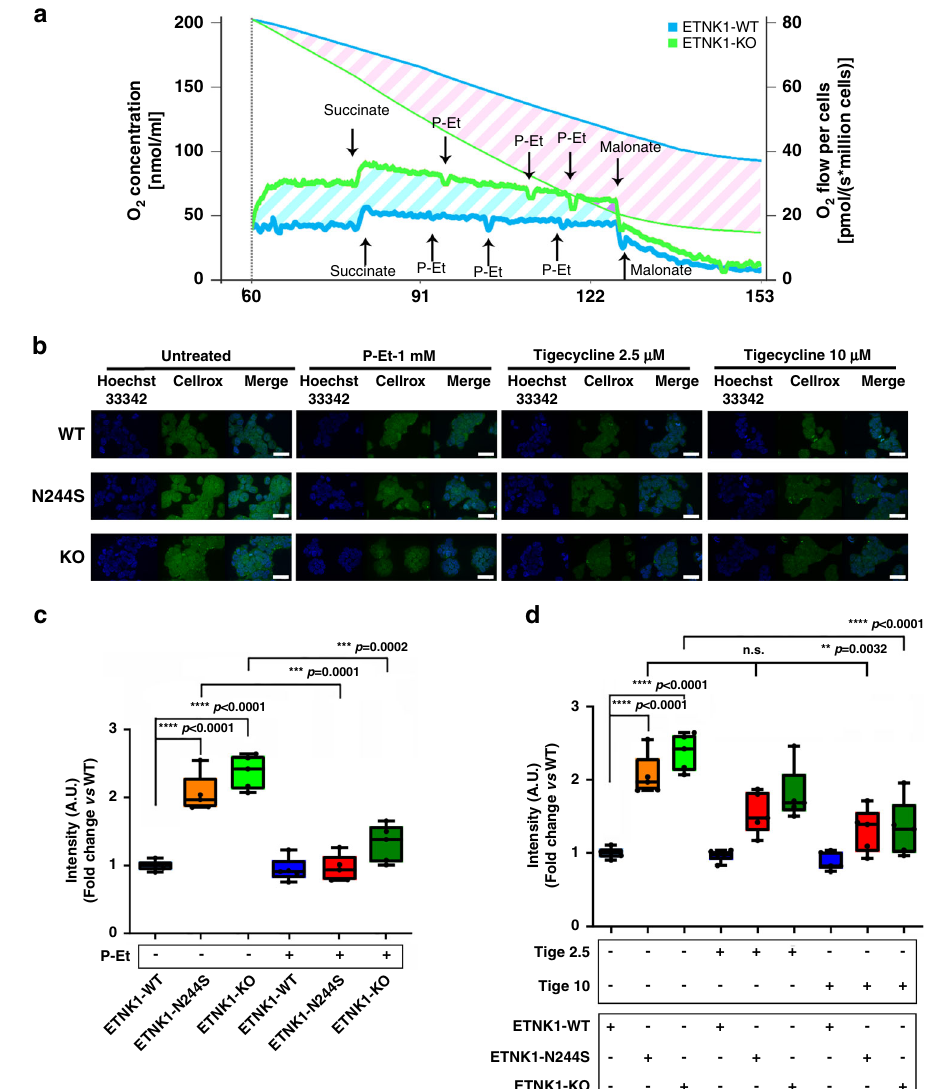
Fig. 3 Mitochondria respiration and ROS production. a Representative graph of O 2 consumption rate (pmol/(s*10 6 cells)) and O 2 concentration (nmol/ ml) in ETNK1-WT and KO CRISPR lines ( n = 4), measured by high-resolution respirometry Oroboros O2K (1 million cells). The thick blue and green lines represent the oxygen consumption rate of ETNK1-WT and KO cells, respectively; the thin blue and green lines show the oxygen concentration in ETNK1- WT and KO oxygraph chambers, respectively. The diagonal cyan and pink stripes highlight, respectively, the difference in oxygen consumption rate and oxygen concentration of ETNK1-WT and KO cells. b Intracellular reactive oxygen species as assessed by confocal microscopy using the CellROX reagent. ROS analysis was performed in ETNK1-WT, N244S, and KO CRISPR lines in the absence and presence of P-Et 1 mM, tigecycline 2.5 µ M and tigecycline 10 µ M. Both the P-Et and the tigecycline treatments lasted 24 h. At least 200 cells were analyzed. The scale bar corresponds to 40 µ m. c ROS quanti fi cation in ETNK1-WT, N244S, and KO CRISPR lines in the absence and presence of 1 mM P-Et. The boxplots delimit the interquartile range; the central bar represents the median; the whiskers extend from minimum to maximum ( n = 5 representative fi elds). Statistical analyses were performed using one-way ANOVA with Tukey ’ s post-hoc test. d ROS quanti fi cation in ETNK1-WT, N244S, and KO CRISPR lines in the absence and presence of 2.5 and 10 µ M tigecycline. The boxplots delimit the interquartile range; the central bar represents the median; the whiskers extend from minimum to maximum ( n = 5 representative fi elds). Statistical analyses were performed using one-way ANOVA with Tukey ’ s post-hoc test. Source data are provided as a Source data fi